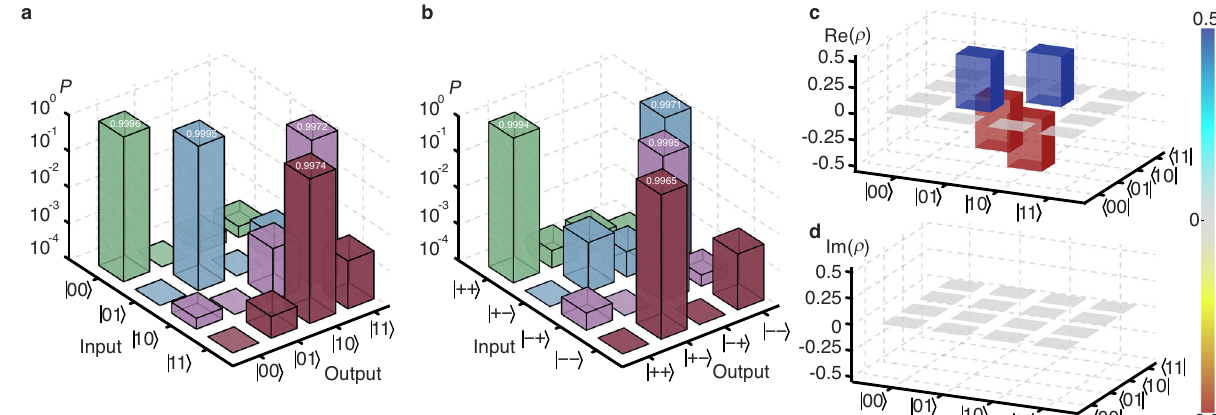
Fig. 3 | High- fi delity photon – photon gate. a , b Truth tables of the CNOT gate in the computational ZZ basis ( a ) and the complementary XX basis ( b ). The ideal input-output relation in the ZZ basis is ∣ 00 i ! ∣ 00 i , ∣ 01 i ! ∣ 01 i , ∣ 10 i ! ∣ 11 i and ∣ 11 i ! ∣ 10 i . Similarly, the ideal input-output relation in the XX basis is ∣ + + i ! ∣ + + i , ∣ + (cid:2)i ! ∣ (cid:2)(cid:2)i , ∣ (cid:2) + i ! ∣ (cid:2) + i and ∣ (cid:2)(cid:2)i ! ∣ + (cid:2)i , with the